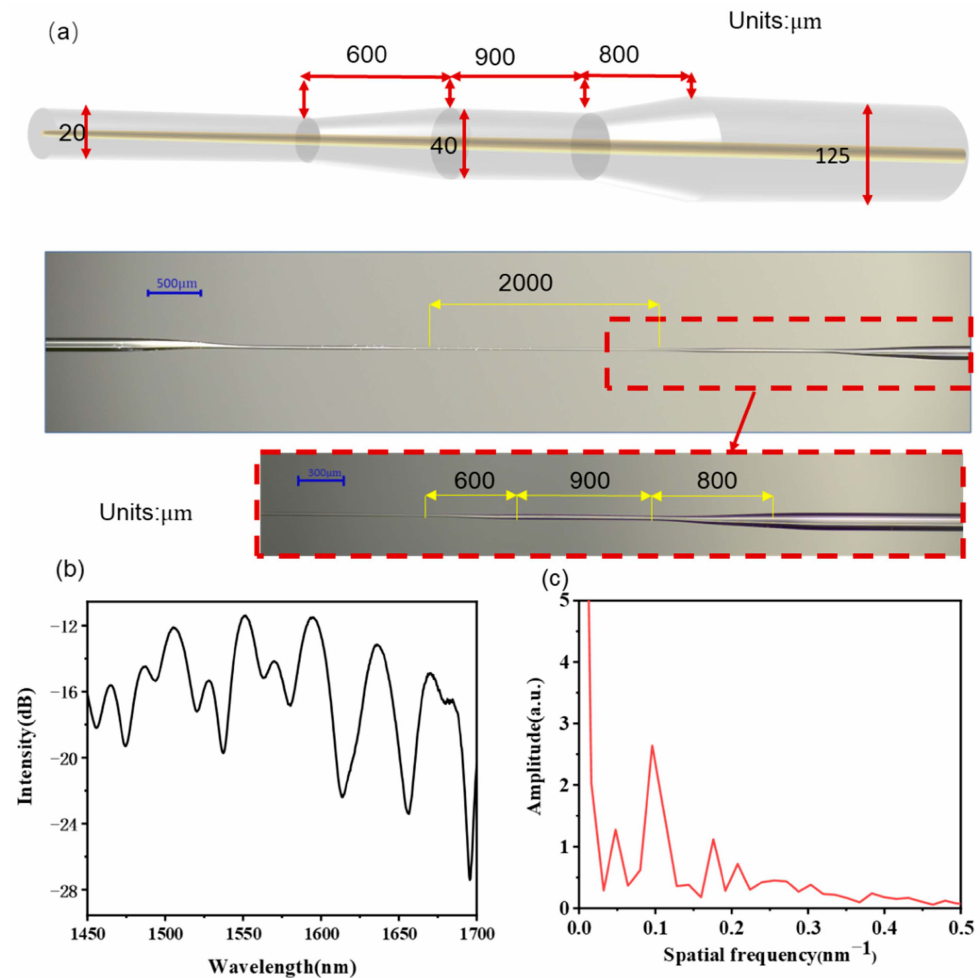
Figure 5. ( a ) Microscope view of the developed sensor; ( b ) Transmission spectra and its ( c ) FFT spectrum. The RI testing result of the optimized taper-in-taper fiber sensor is shown in Figure 6. With regard to the variation of the transmission optical spectrum of the sensor in 13 different RI liquids, the redshift occurs towards the interference fringe peaks and valleys along with the increase in liquid RI. A sensitivity of 1552 nm/RIU was obtained when the prepared liquids RI varies from 1.33300 to 1.38027, and even reach as high as 2741 nm/RIU when the liquid RI between 1.38027 and 1.40169. Obviously, an abrupt change in sensitivity occurred around RI 1.38. This may because the penetration depth of the evanescent wave would increase along with the external refractive index, thus more evanescent waves can break through the cladding and propagate forward along the surface of the cladding in the external medium environment. Therefore, when the external environment changes, varia- tions in the evanescent wave would occur correspondingly, so as to realize the detection of external parameters with enhanced sensitivity, which has been previously reported then proved